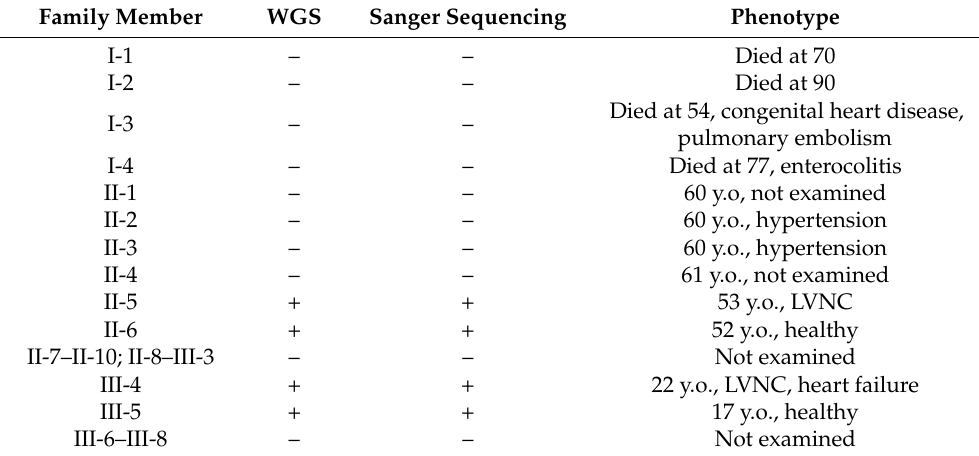
Figure 1. Pedigree of the family (created using the CeGaT Pedigree Chart Designer software v3.0, (CeGaT GmbH, Tübingen, Germany) [16]). Women are shown by circles and men by squares. Affected persons are shown by black figures, crossed figures indicate deceased people. The proband (III-4) is indicated by the arrow. Table 1. Pedigree description.